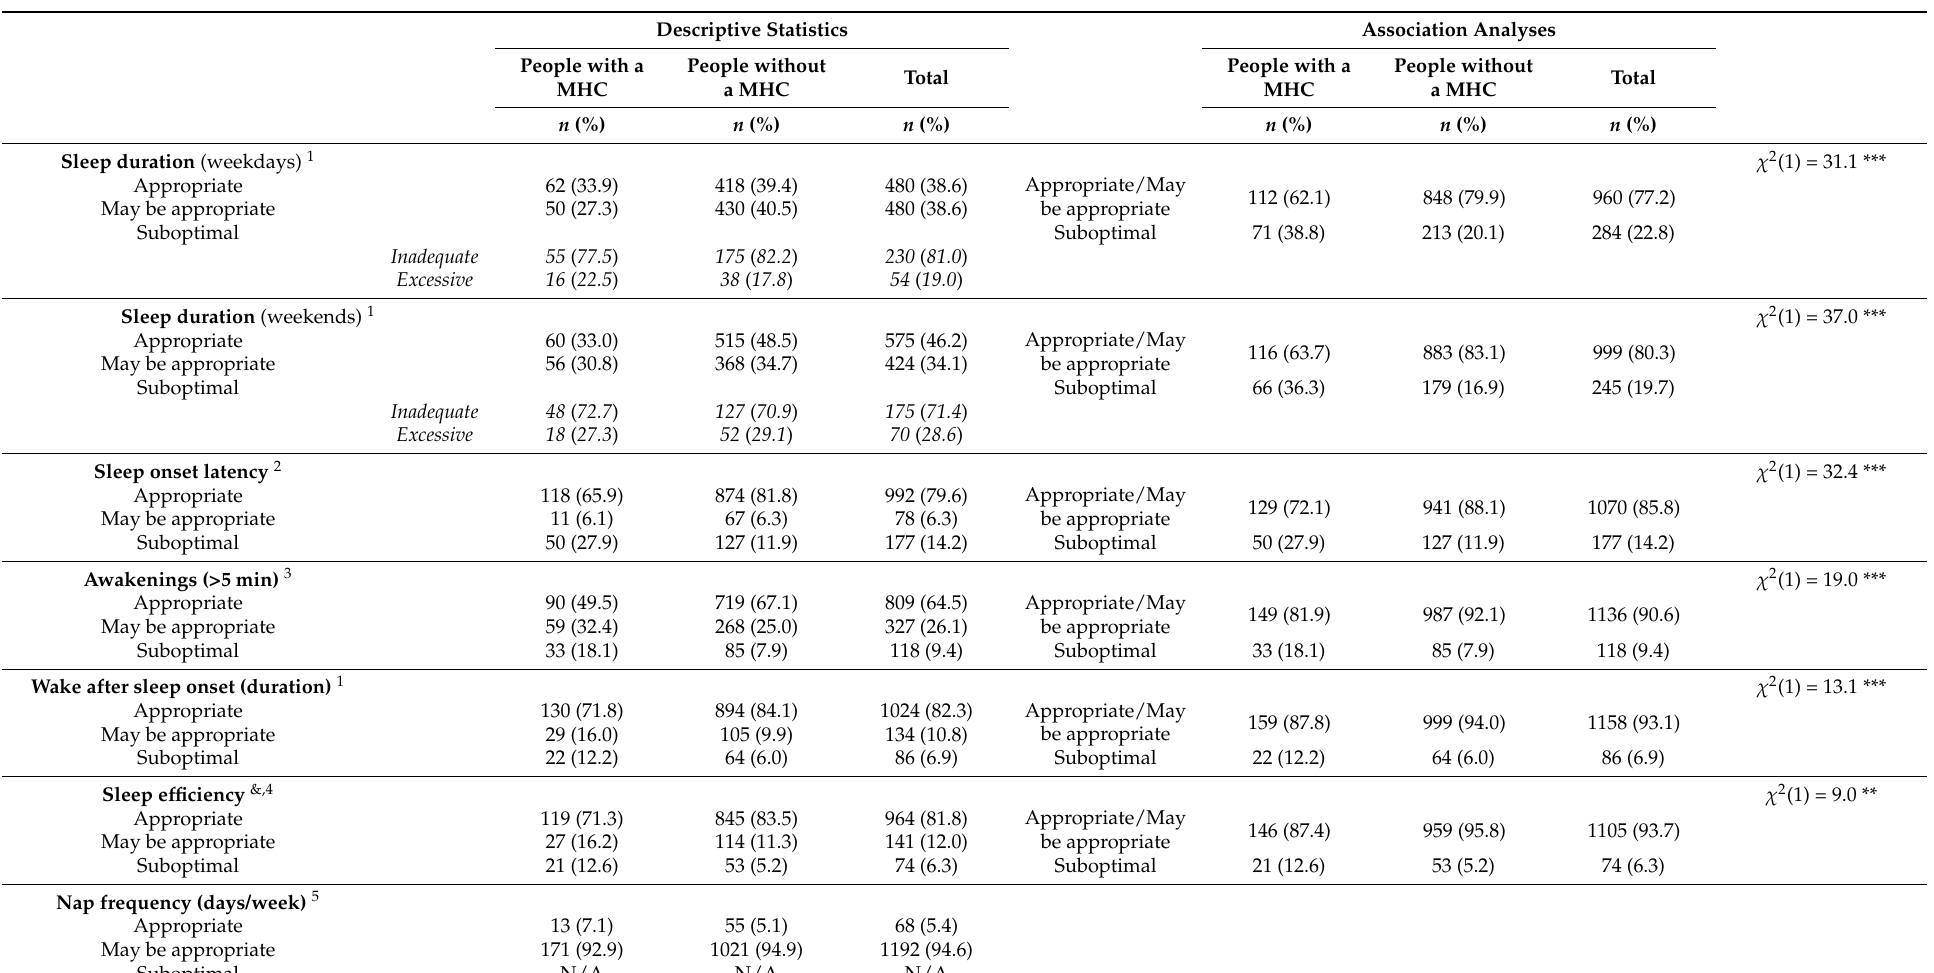
Table 2. Prevalence of Suboptimal Sleep among People with and without a Mental Health